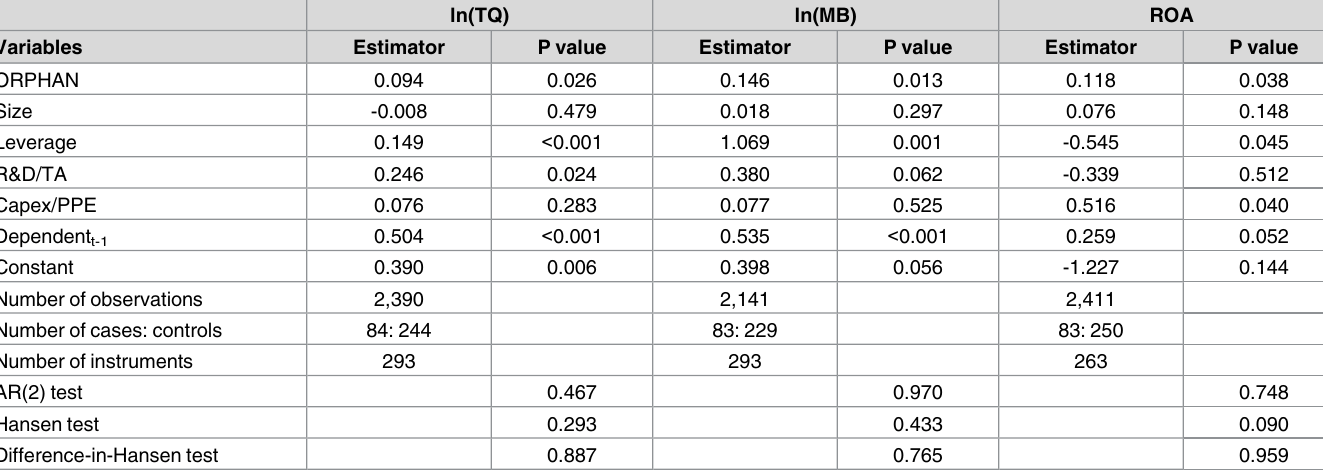
Table 4. The impact of orphan drug company status on company